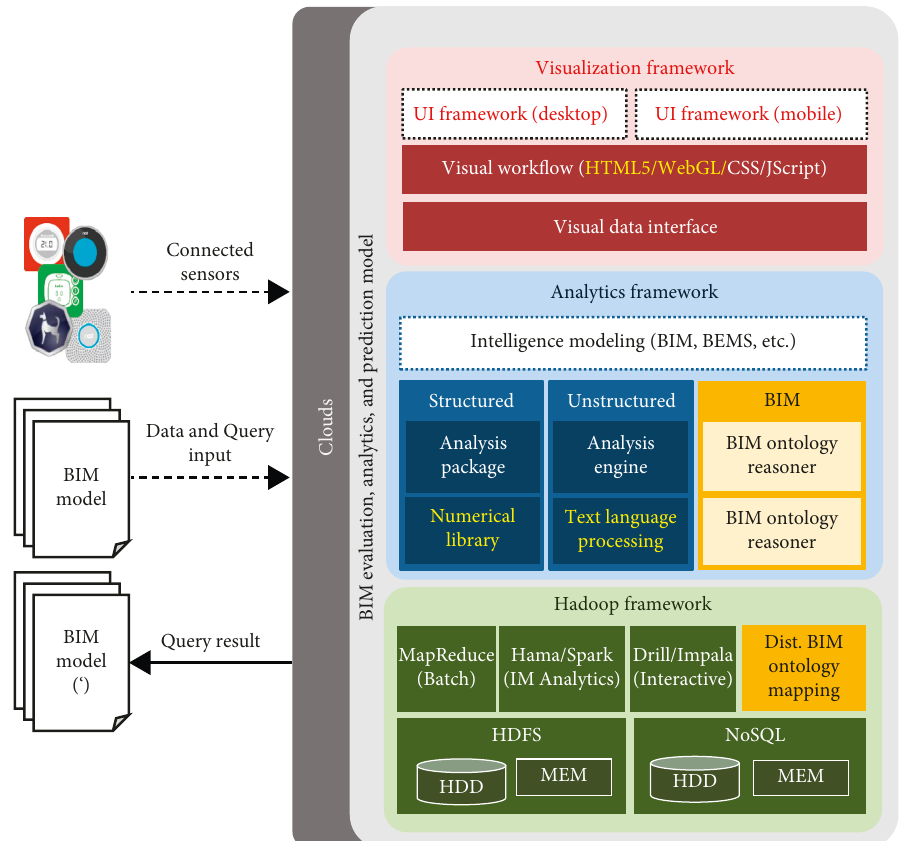
Figure 7: BIM evaluation, analytics, and prediction (EAP) framework and platform.